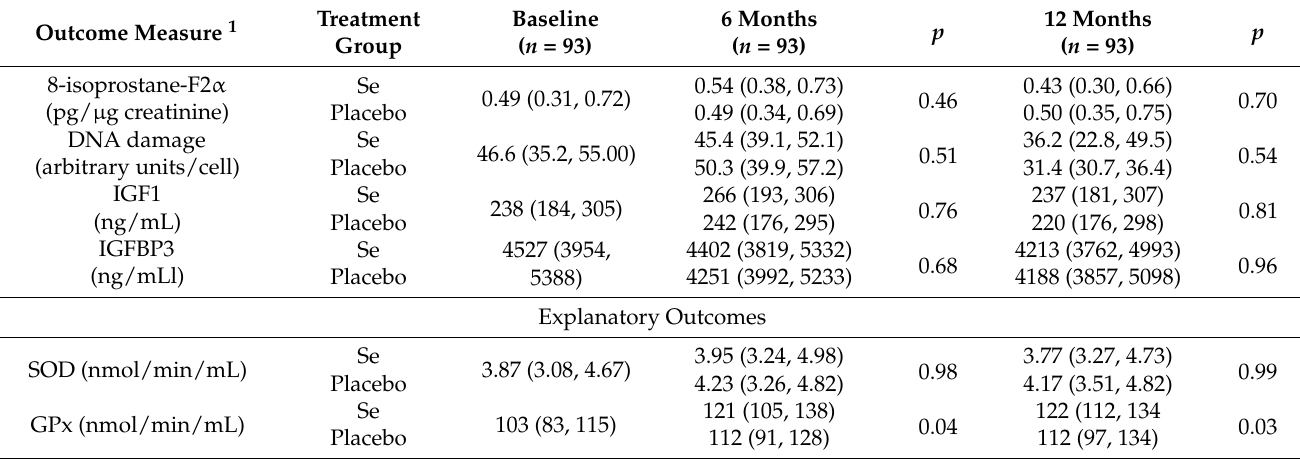
Table 3. Outcome Measures at Baseline and Follow-up.